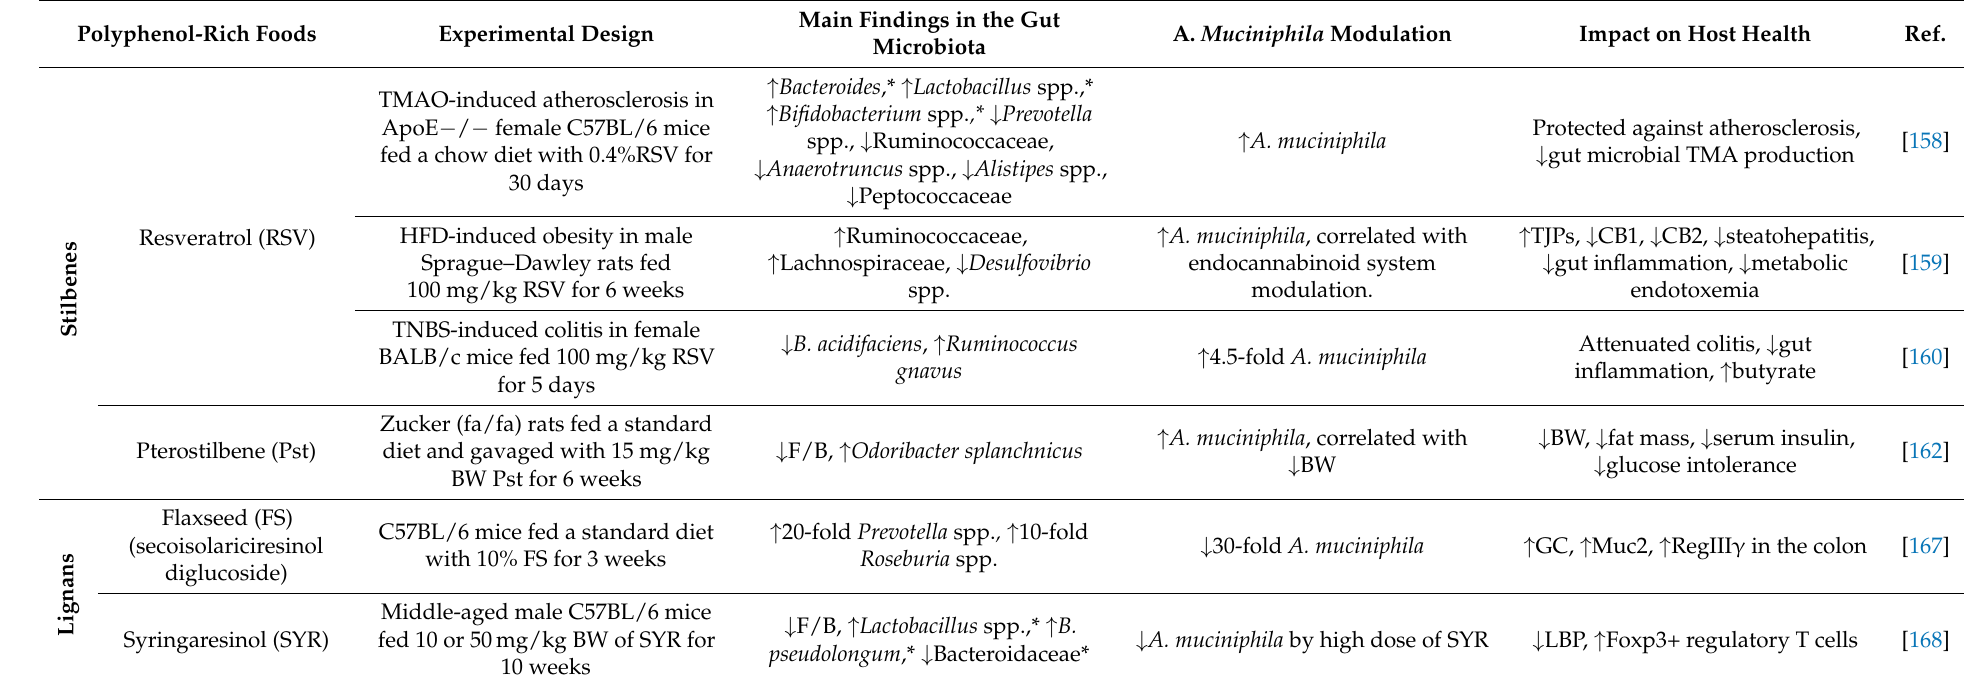
Table 6. Modulation of the gut microbiota and A. muciniphila by stilbenes and lignans in